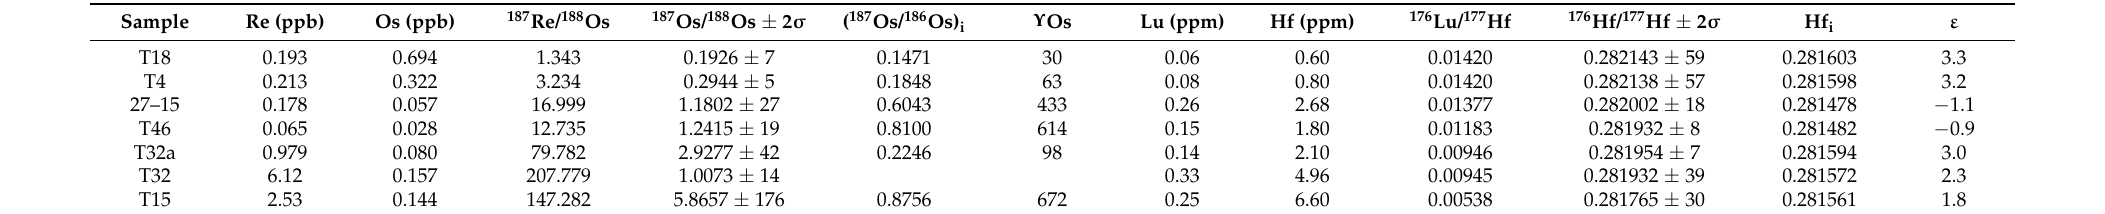
Table 3. Whole rock Re-Os and Lu-Hf isotopic data on the Tiksheozero complex.